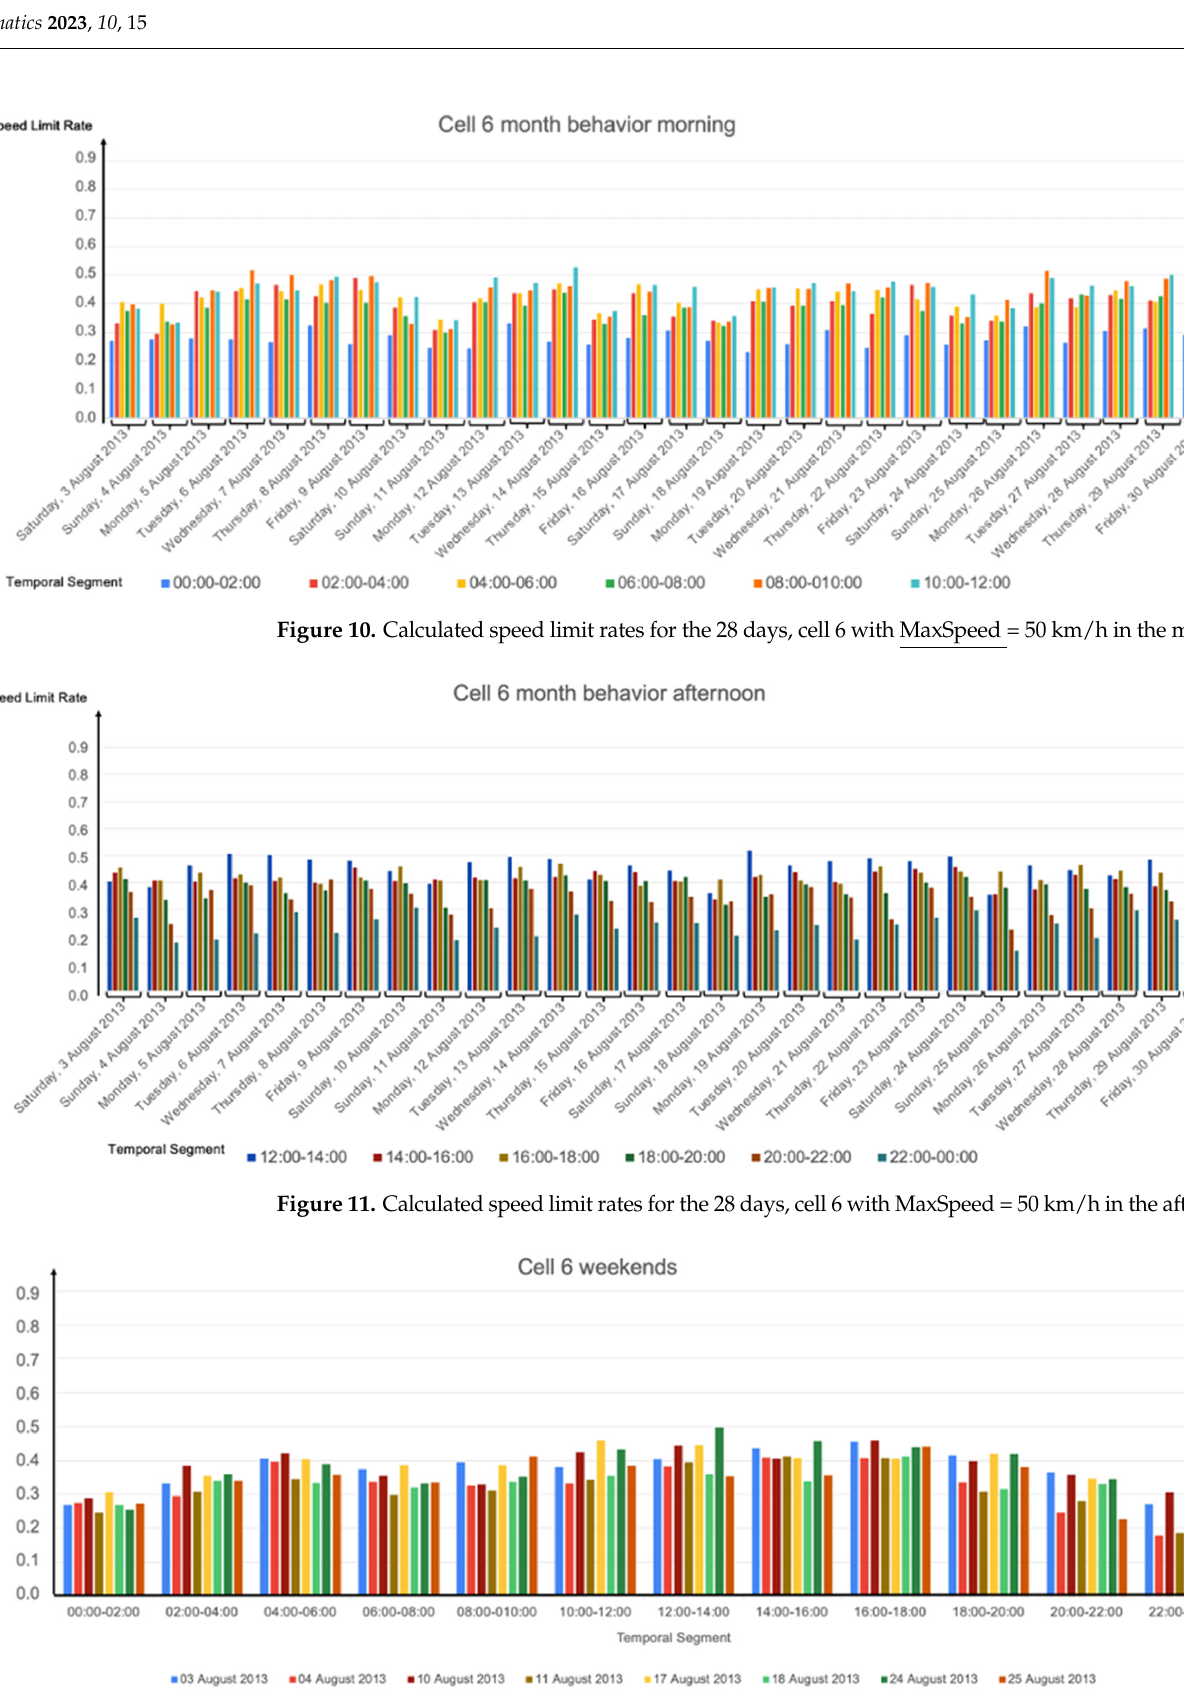
Figure 12. Calculated speed limit rates for the weekends, cell 6 with MaxSpeed = 50